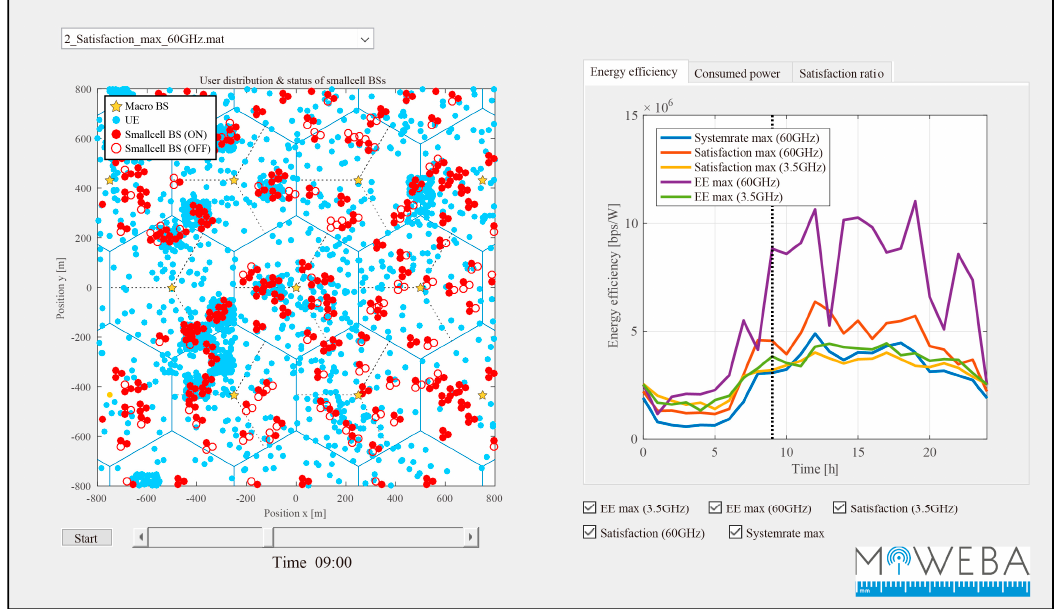
Figure 17. Snapshot of small cell on/off ( left ) and its energy efficiency ( right ).